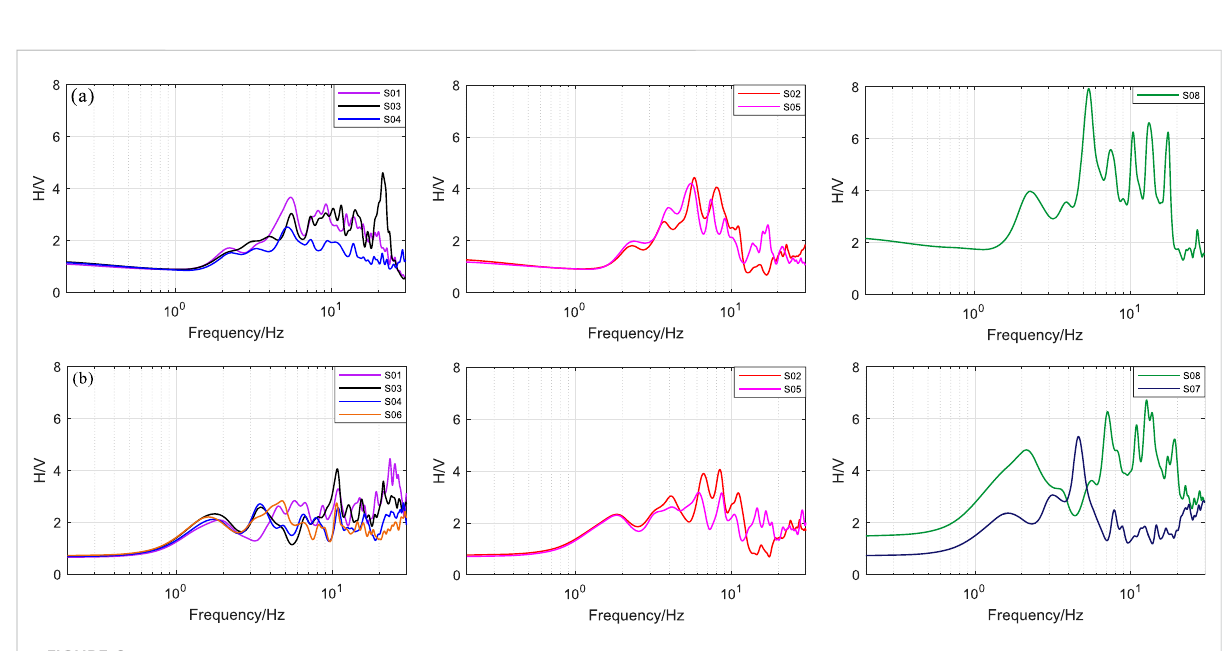
FIGURE 6 Response spectral H/V ratio of each soil station: (A) H/V ratios of the Luxian earthquake and (B) H/V ratios of the Yibin